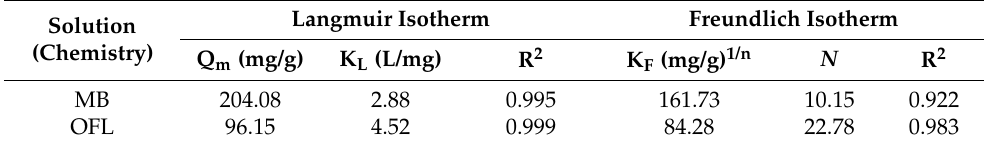
Table 1. SAC adsorption MB and OFL adsorption isotherm fitting